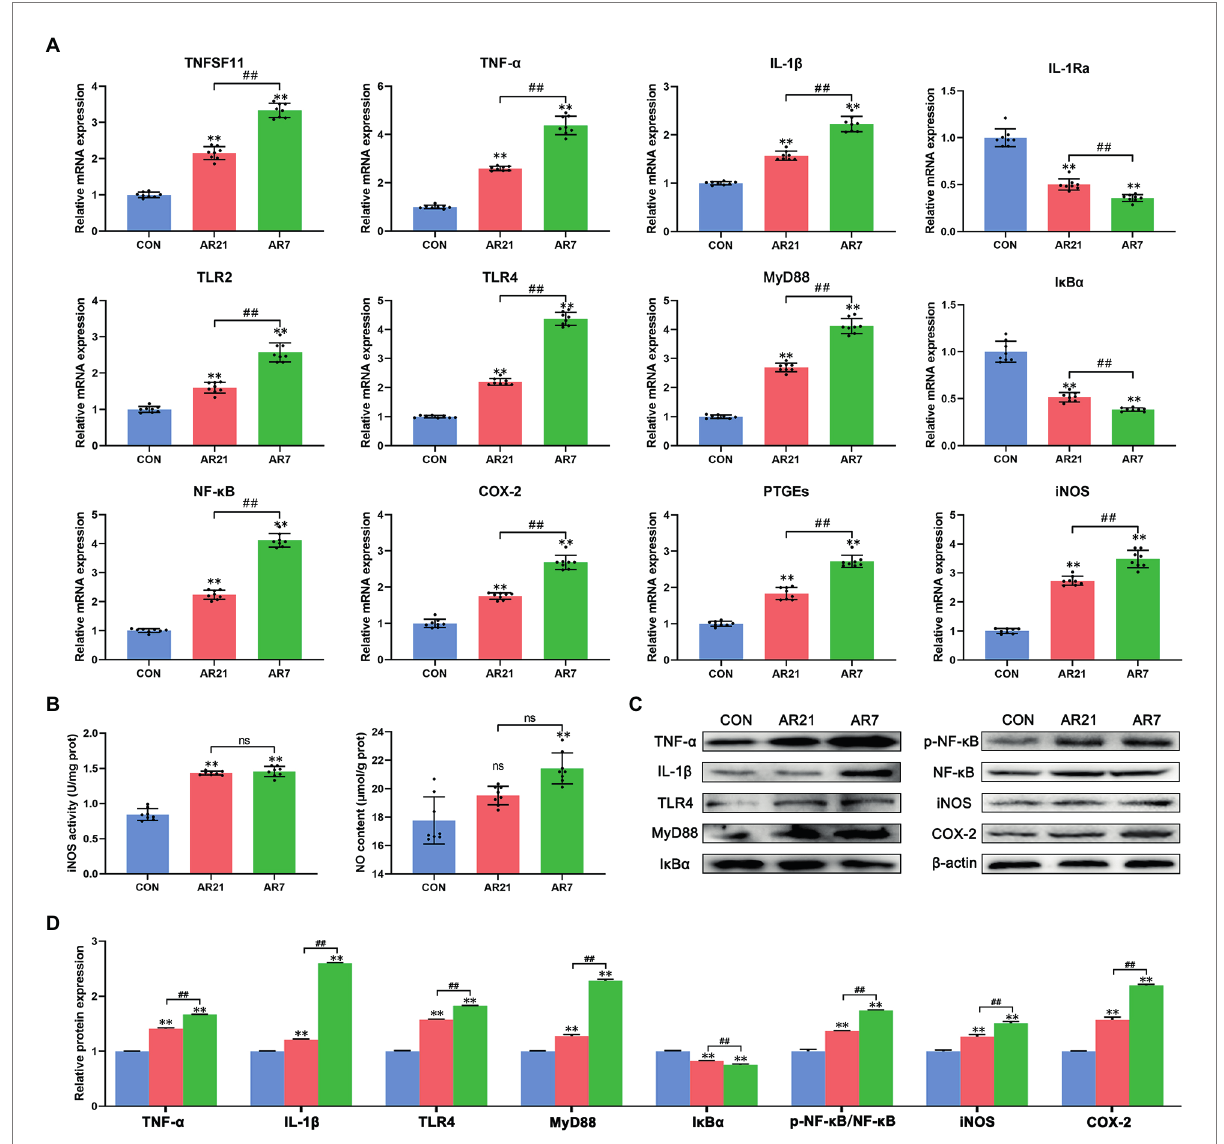
FIGURE 7 Effects of artificial rearing on NF- κ B pathway and its downstream genes in piglet colon. (A) Relative mRNA expression of NF- κ B pathway genes. (B) iNOS activity and NO content. (C,D) Relative expression of NF- κ B pathway proteins and it downstream proteins. Data are presented with mean ± SD. ns p > 0.05; ** p < 0.01 versus the CON group; ## p < 0.01 versus the AR21 group. n = 8